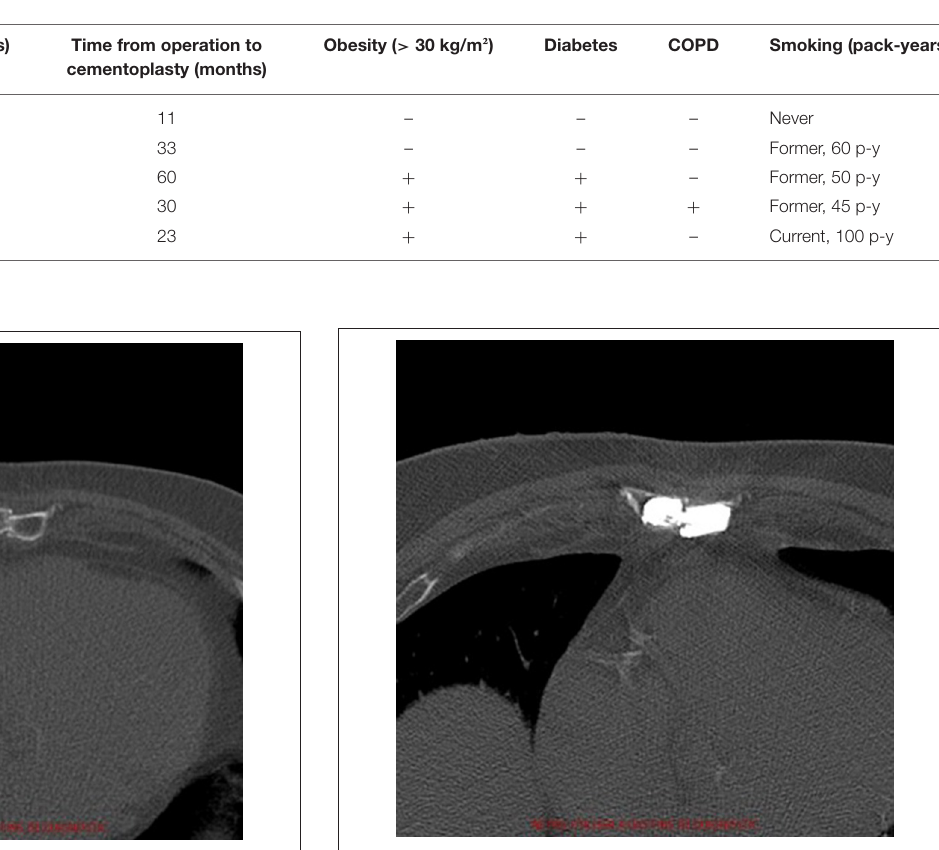
FIGURE 2 | Post-operative axial computed-tomography image of patient 1. The radiopaque cement fills the pseudathrosic parts of the sternum to reduce the pain and a bridge is created for a better